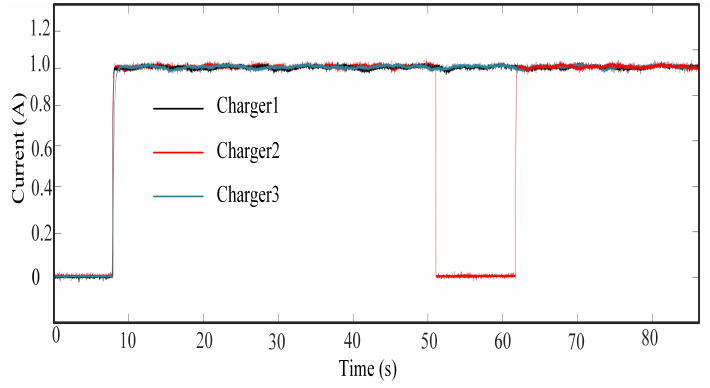
Figure 8. Experiment results of ( a ) the classical charging method and ( b ) the proposed charging method in total charging current.